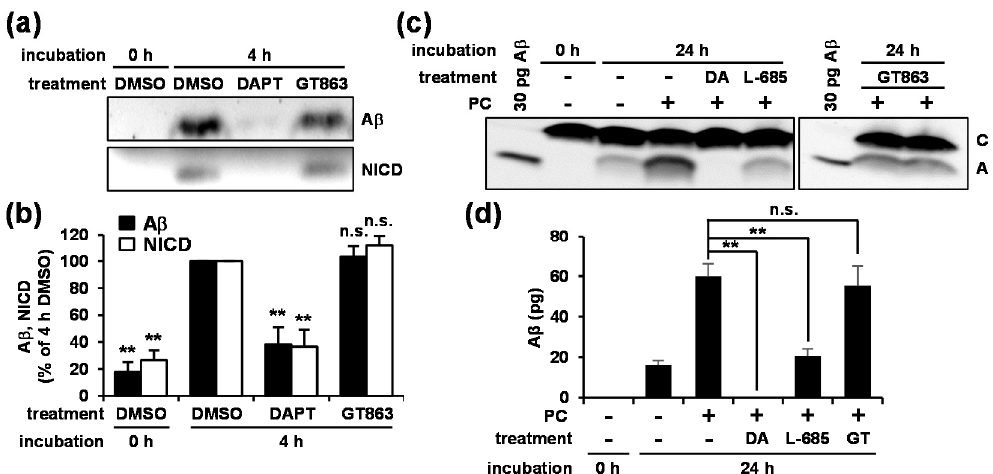
Figure 3. Effect of GT863 on in vitro γ -secretase activity. ( a ) 3-[(3-cholamidopropyl)dimethylammonio]-2-hydroxypropanesulfonate (CHAPSO)-solubilized microsomal fractions of CHO cells and substrates were incubated with or without 1 μ M N-[N-(3,5-difluorophenacetyl)-L-alanyl]-S-phenylglycine t-butyl ester (DAPT) or 3 μ M GT863 for 4 h at 37 °C. After incubation, reaction mixtures were subjected to immunoblotting with appropriate antibodies specific for A β or Notch intracellular domain (NICD). ( b ) Band intensities were quantified by densitometric scanning, relative intensity being shown. Mean ± SD n = 3, ** p < 0.01, n.s. = not significant. ( c ) CHAPSO-solubilized microsomal fractions of yeast transformants were incubated in the presence of 1 mg/ml phosphatidylcholine (PC) with or without 1 μ M DAPT (DA), 1 μ M L-685,458 (L-685), or 3 μ M GT863 for 24 h at 37 °C. After incubation, reaction mixtures were subjected to immunoblotting. Synthetic A β 40 (30 pg) was loaded as a marker. ( d ) Band intensities were quantified by densitometric scanning, relative intensity being shown. mean ± SD n = 3, ** p < 0.01, n.s. = not significant.